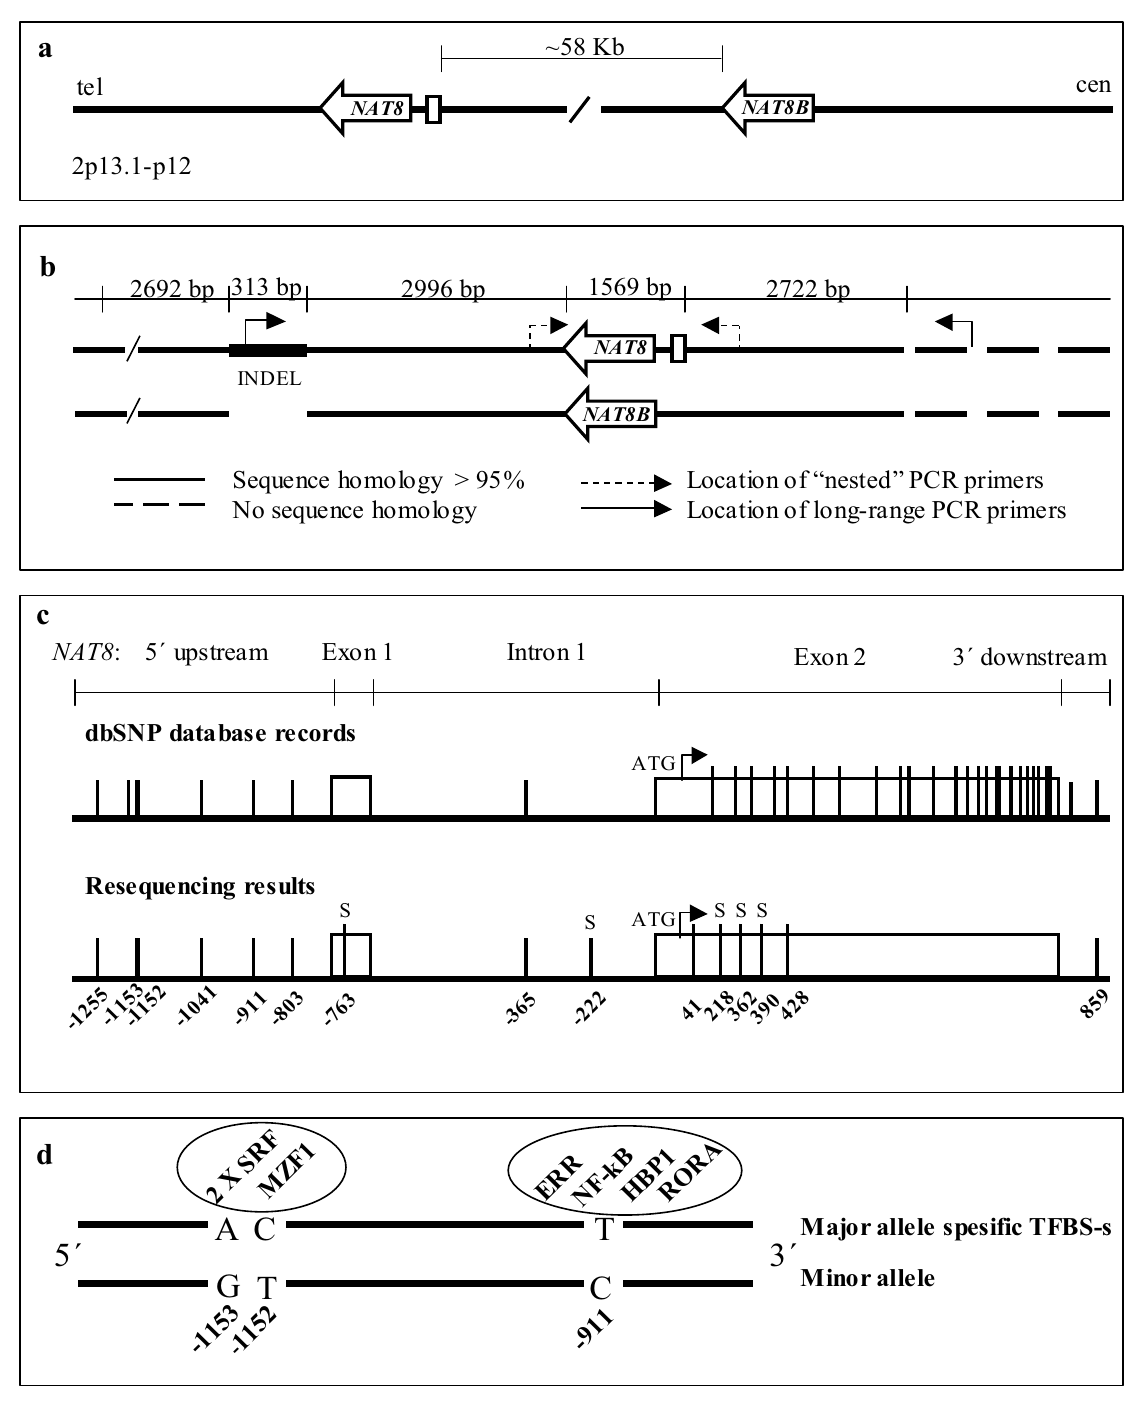
Figure 1 (a) The structure of NAT8/NAT8B cluster: NAT8 / NAT8B location in chromosome 2p13.1-p12; (b) Schematic presentation of the alignment of NAT8 / NAT8B and their flanking regions and the positioning of NAT8 -specific PCR primers; (c) NAT8 resequencing results and SNP positions compared to dbSNP database records; (d) Missing Binding Sites for Transcription Factors (TFBS) on chromosomes carrying the minor alleles of SNPs - 911, -1151 and -1153. "S" – singleton